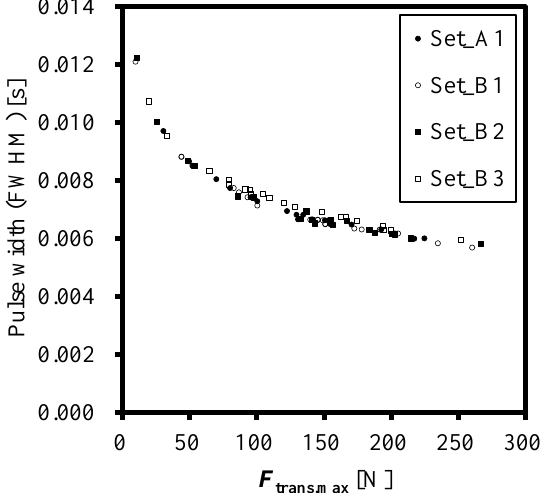
Figure 6. Pulse widths of F three